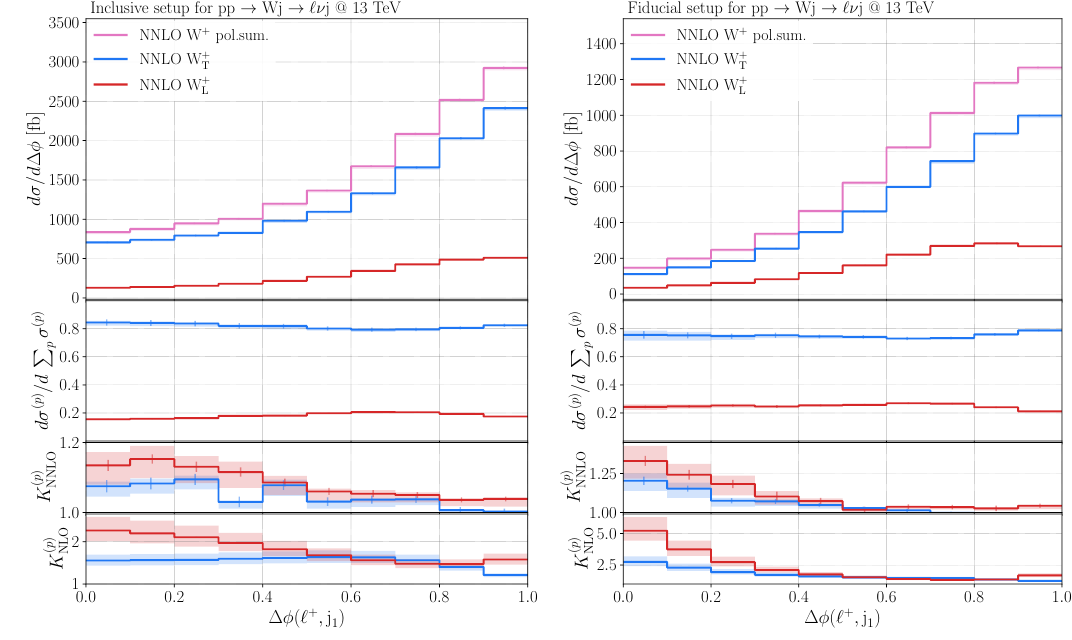
) . Same plot structure as in figure 2. 1